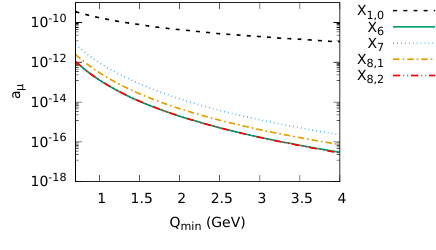
Figure 3. Contributions from X 1 , 0 , X X